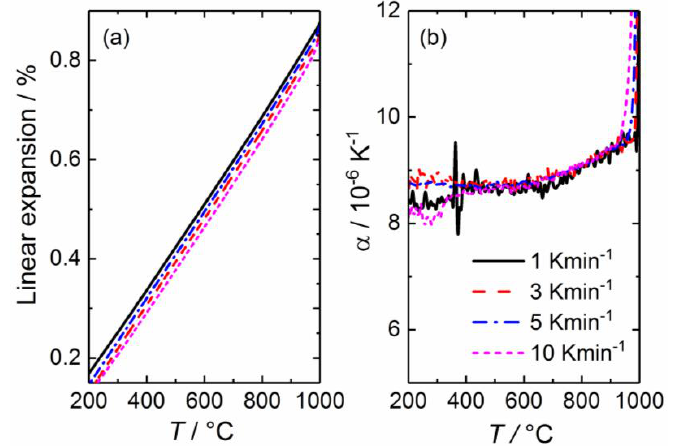
Figure 4. Linear expansion ( a ) and its corresponding first order derivative ( b ) plotted as a function of temperature for BZCY72 for all heating rates except 20 K min − 1 (1 – 10 K min − 1 ), dry Ar. Average thermal expansion coefficients of BZCY72 for the two respective temperature intervals, from 8.5 – 8 .8 × 10 − 6 to around 9.3 × 10 − 6 K − 1 . The distinct difference in the coefficients could be due to